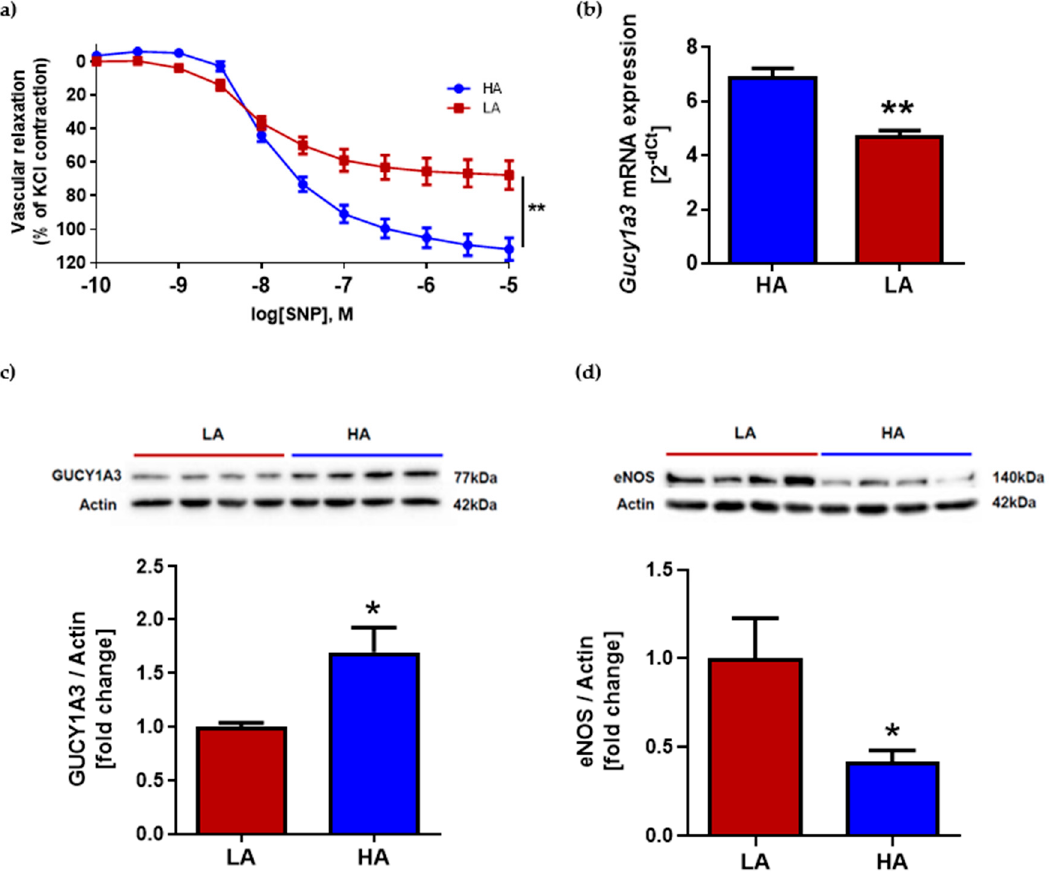
Figure 3. ( a ) Vascular relaxation of aortas from HA and LA mice in response to SNP; ( b ) expression of guanylyl cyclase mRNA in aorta of HA and LA mice ( n = 8); ( c ) GUCY1A3 protein level in aorta of HA and LA mice ( n = 4) corrected to actin; ( d ) eNOS protein level in aorta of HA and LA mice ( n = 4) corrected to actin.* p < 0.05, ** p < 0.01.